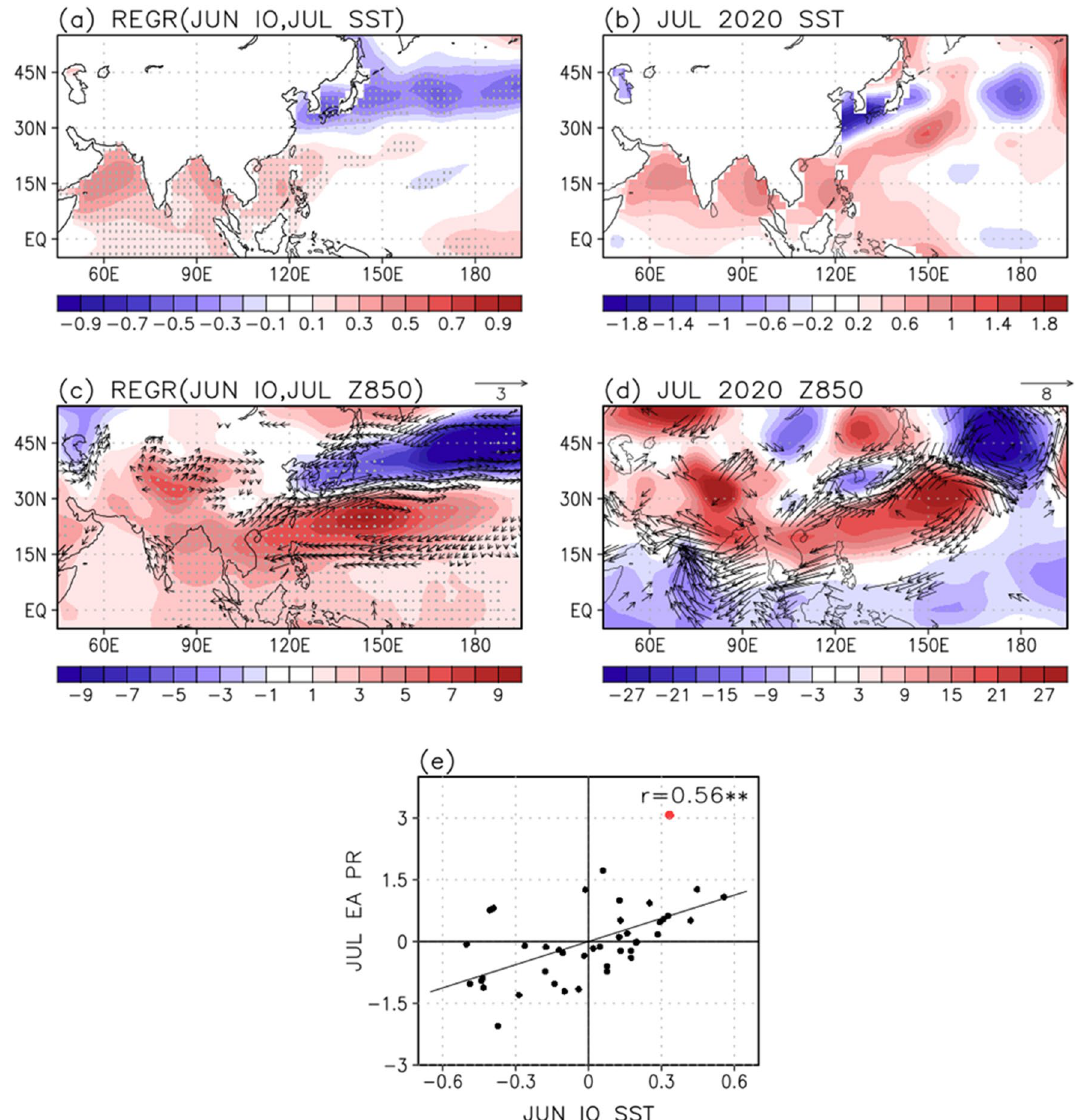
Figure 3. Regressed ( a ) SST (°C), ( c ) geopotential height (shading; m) and wind (vectors; m/s) anomalies at 850 hPa in July onto the Indian Ocean (45°–100° E, 0°–25° N) SST in June during 1979–2020. Note that the regression coefficients are multiplied by the value of Indian Ocean SST in June 2020. Values over the 95% confidence level based on the student t-test are stippled and represented as vectors. ( b ) SST, ( d ) geopotential height and wind anomalies at 850 hPa in July 2020. ( e ) Scatter diagram between the Indian Ocean SST in June and East Asian (105°–150° E, 25°–40° N) rainfall index in July. The value for 2020 is indicated by the red dot. The symbol of ** denotes the 99% confidence level based on the student